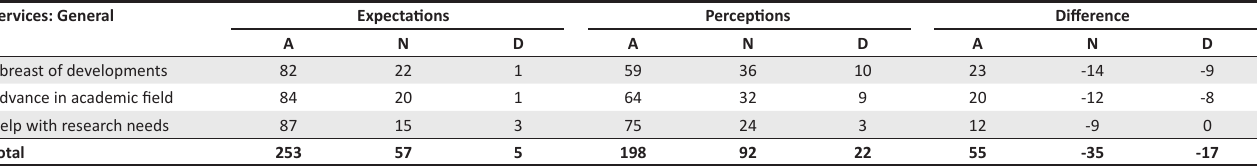
TABLE 6: Library services consisting of research and academic fields. Services: